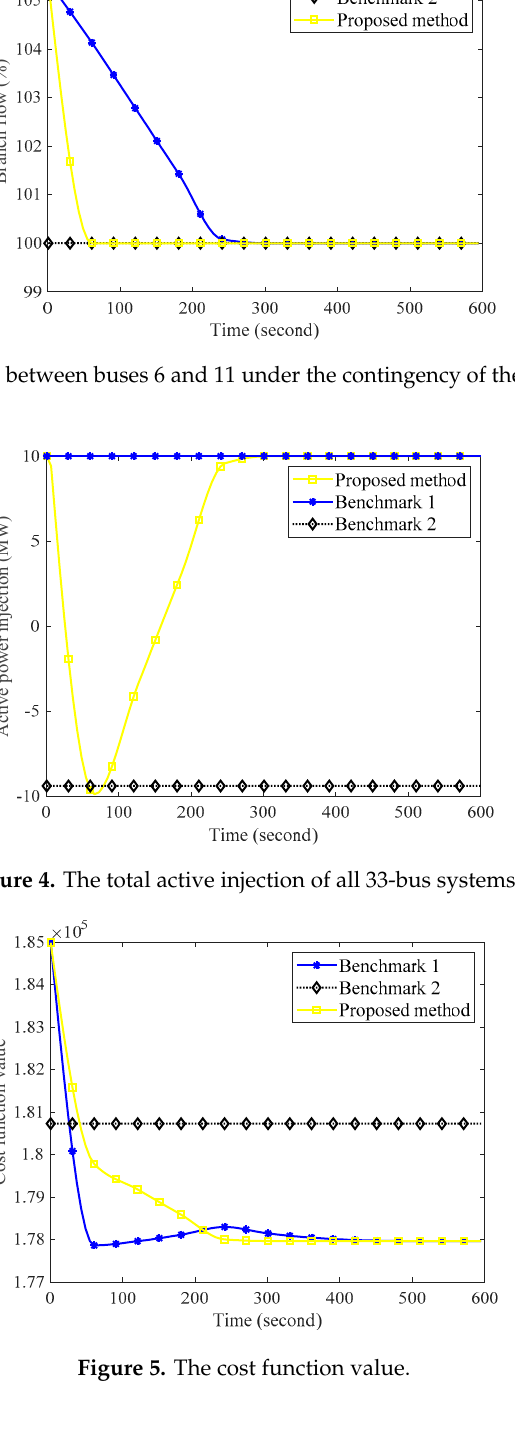
Figure 5. The cost function value.